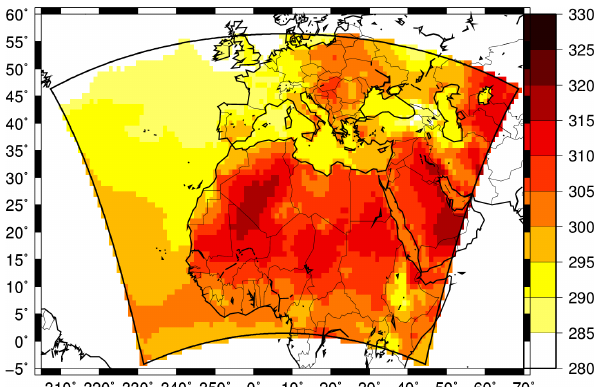
Figure 5. The simulation domain for WRF and CHIMERE. A Lam- bert conformal projection is used with a constant horizontal reso- lution of 60km × 60km. Colors represent the 2m temperature (in Kelvin) for 21 June